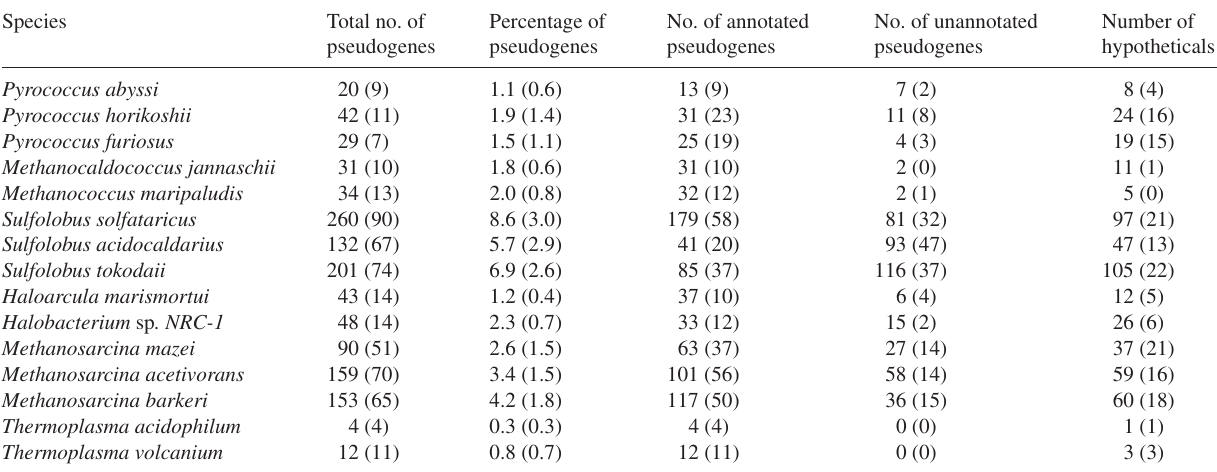
Table 1. Numbers, proportions and characteristics of pseudogenes in the Archaea. Numbers depicted are the total number of predicted pseudo- genes, with bracketed numbers indicating the number of positional